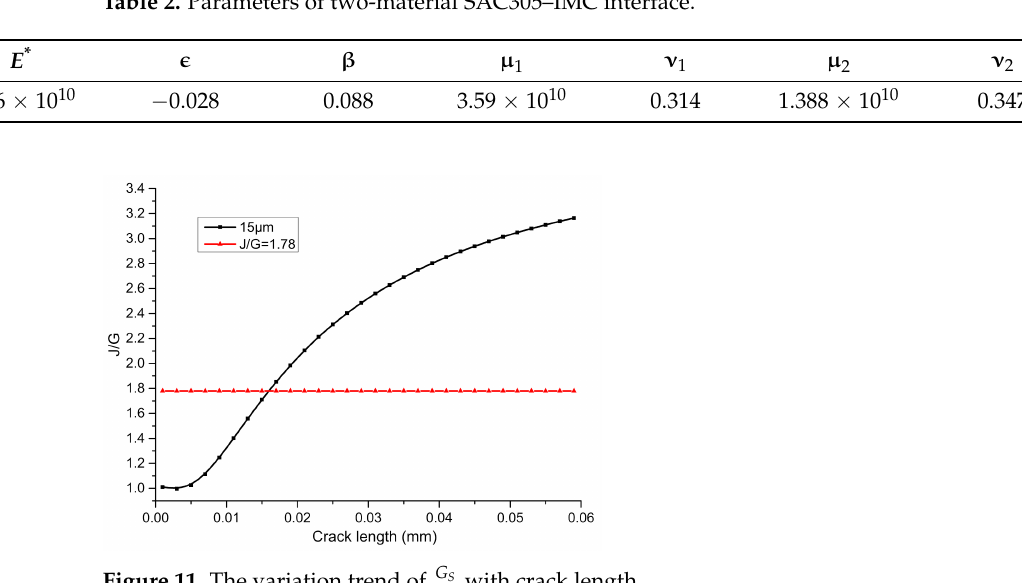
Figure 11. The variation trend of G S